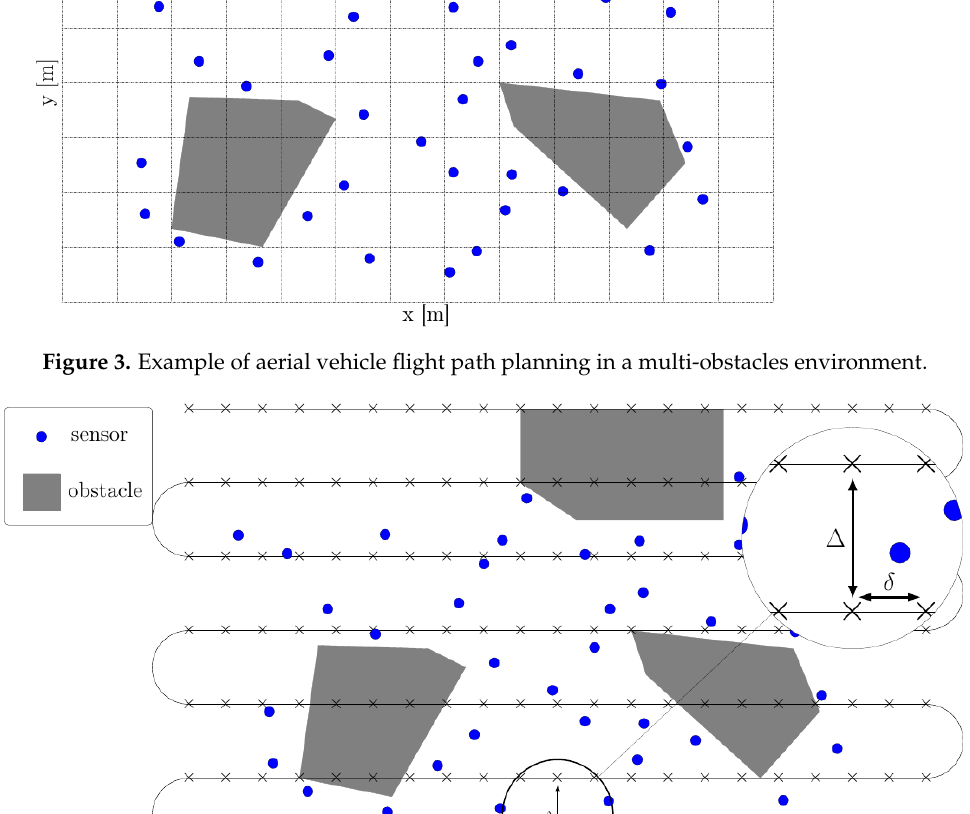
Figure 3. Example of aerial vehicle flight path planning in a multi-obstacles environment.